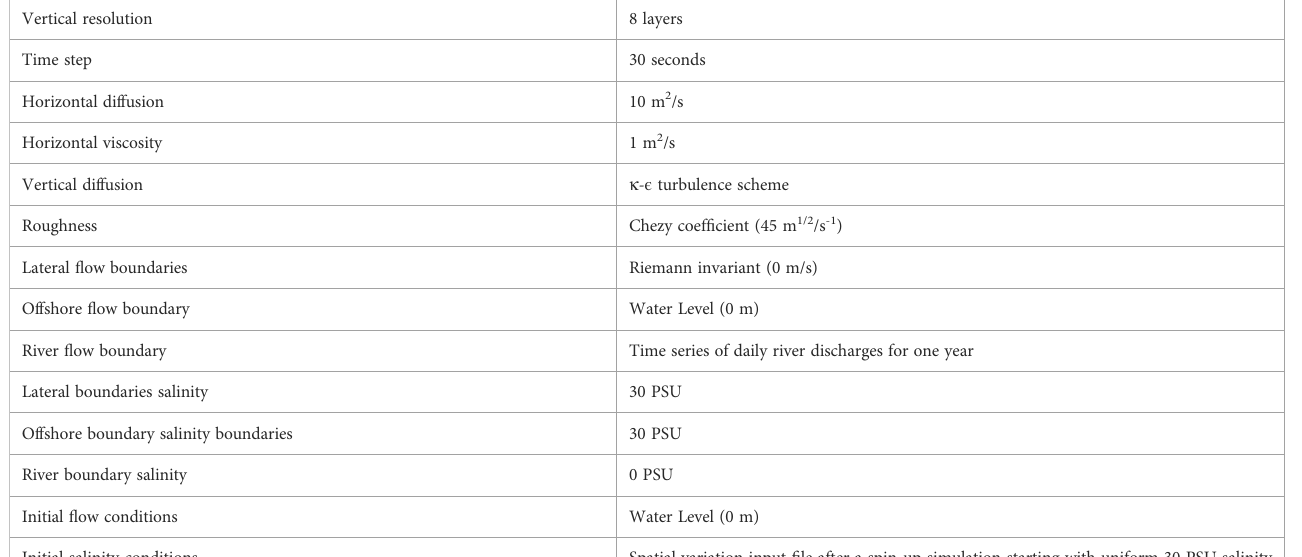
TABLE 2 Summary of the main model setup